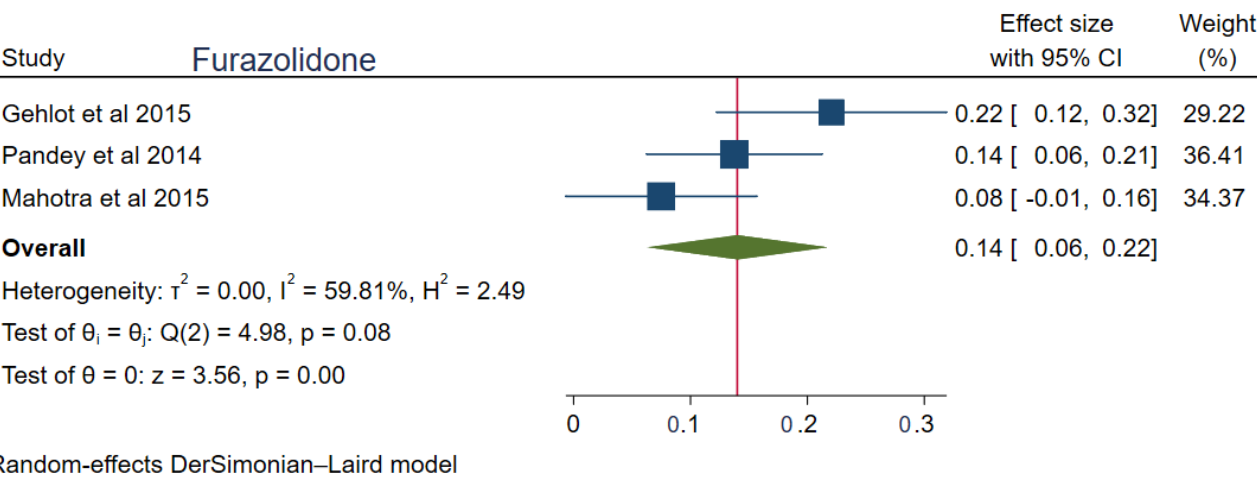
Table 2. Country-wise Antibiotic Resistance Patterns